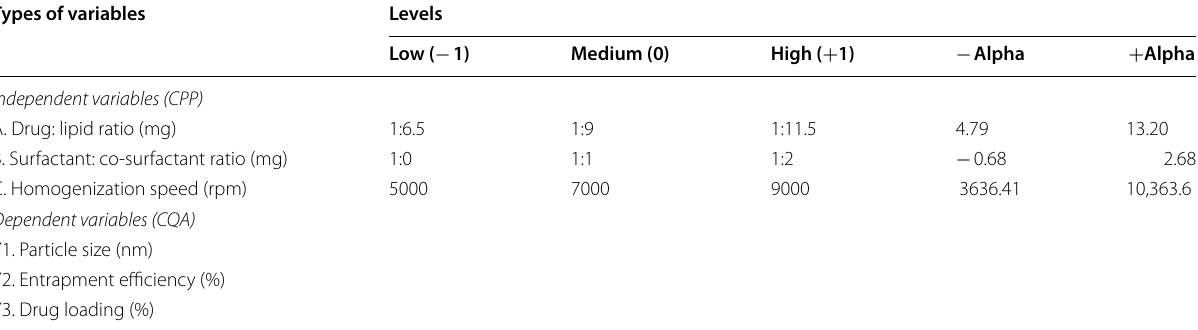
CPP, critical process parameters; CQA, critical quality attributes; mg, milligram; nm, nanometer; rpm, rotation per minute; %,